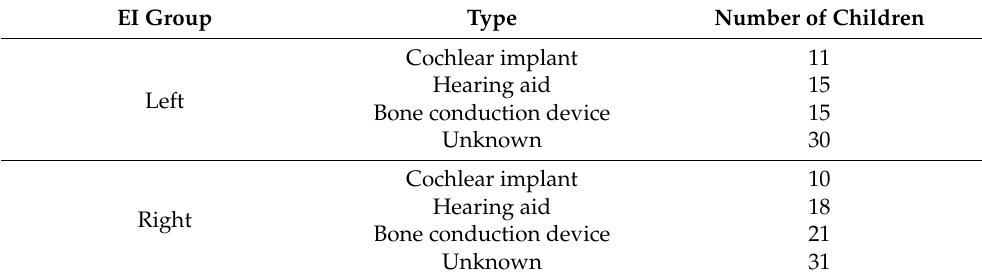
Table 5. Early Intervention (EI) group by device used (unilateral hearing loss).